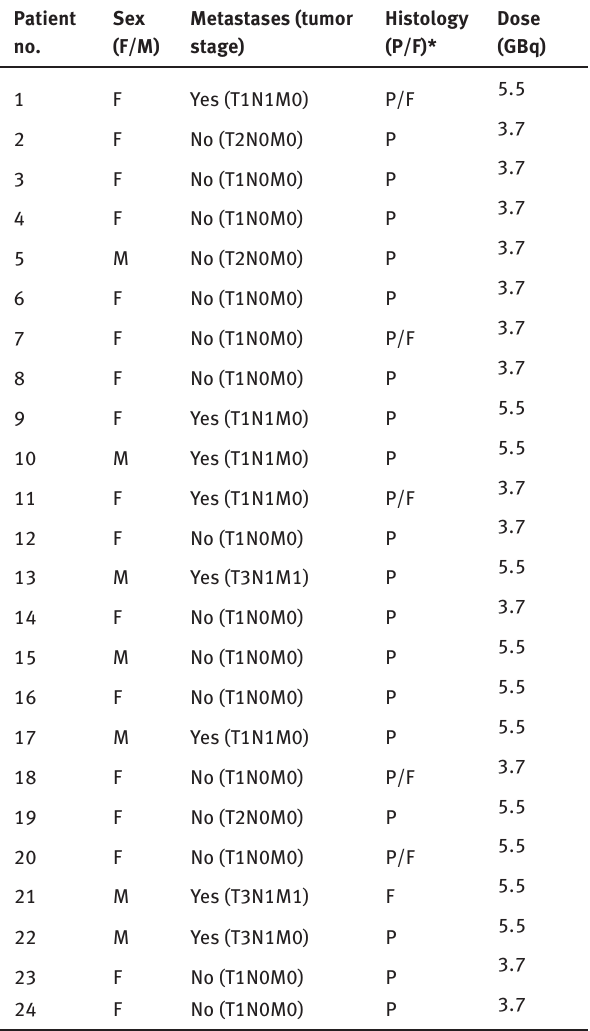
Table 1: Characteristics of 24 thyroid cancer patients treated with